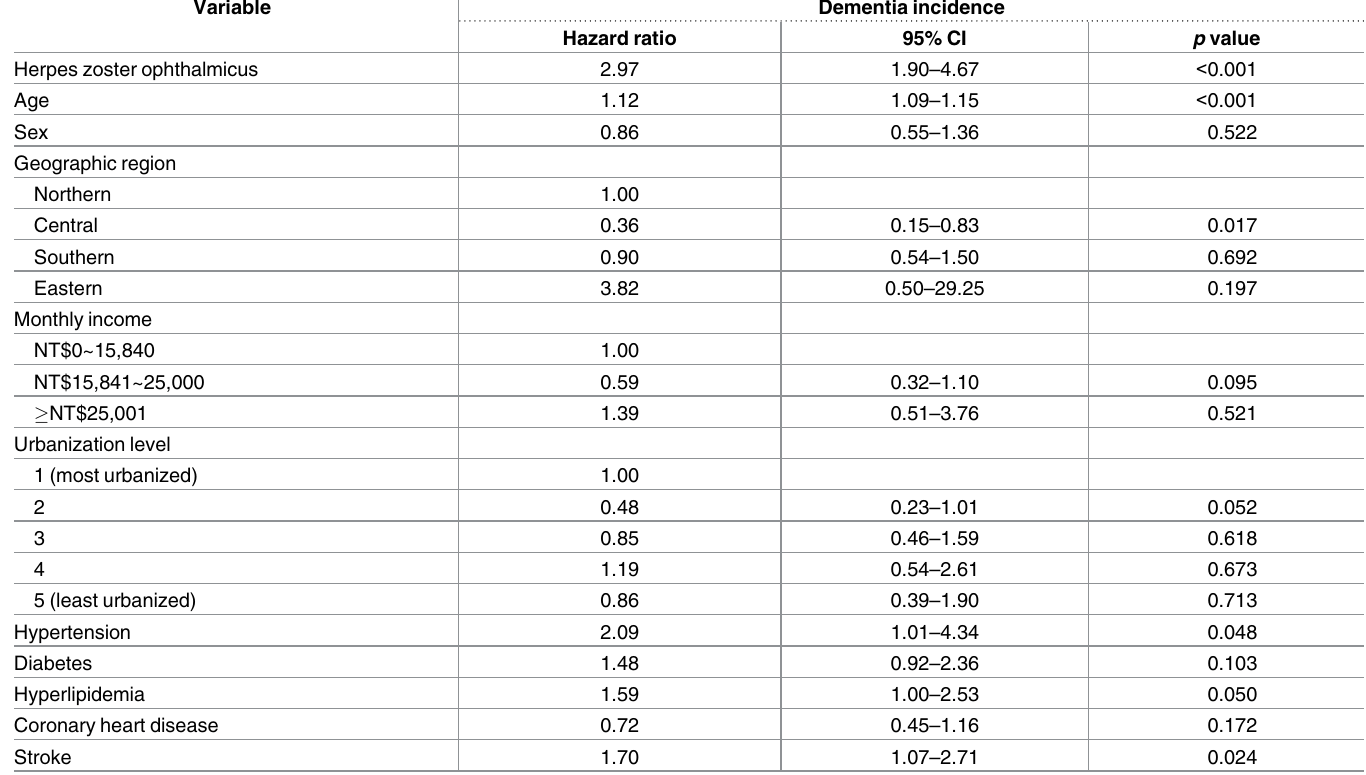
Table 3. Covariate-adjusted hazard ratios (HRs) for the occurrence of dementia during the 5-year follow-up period among patients with herpes zoster